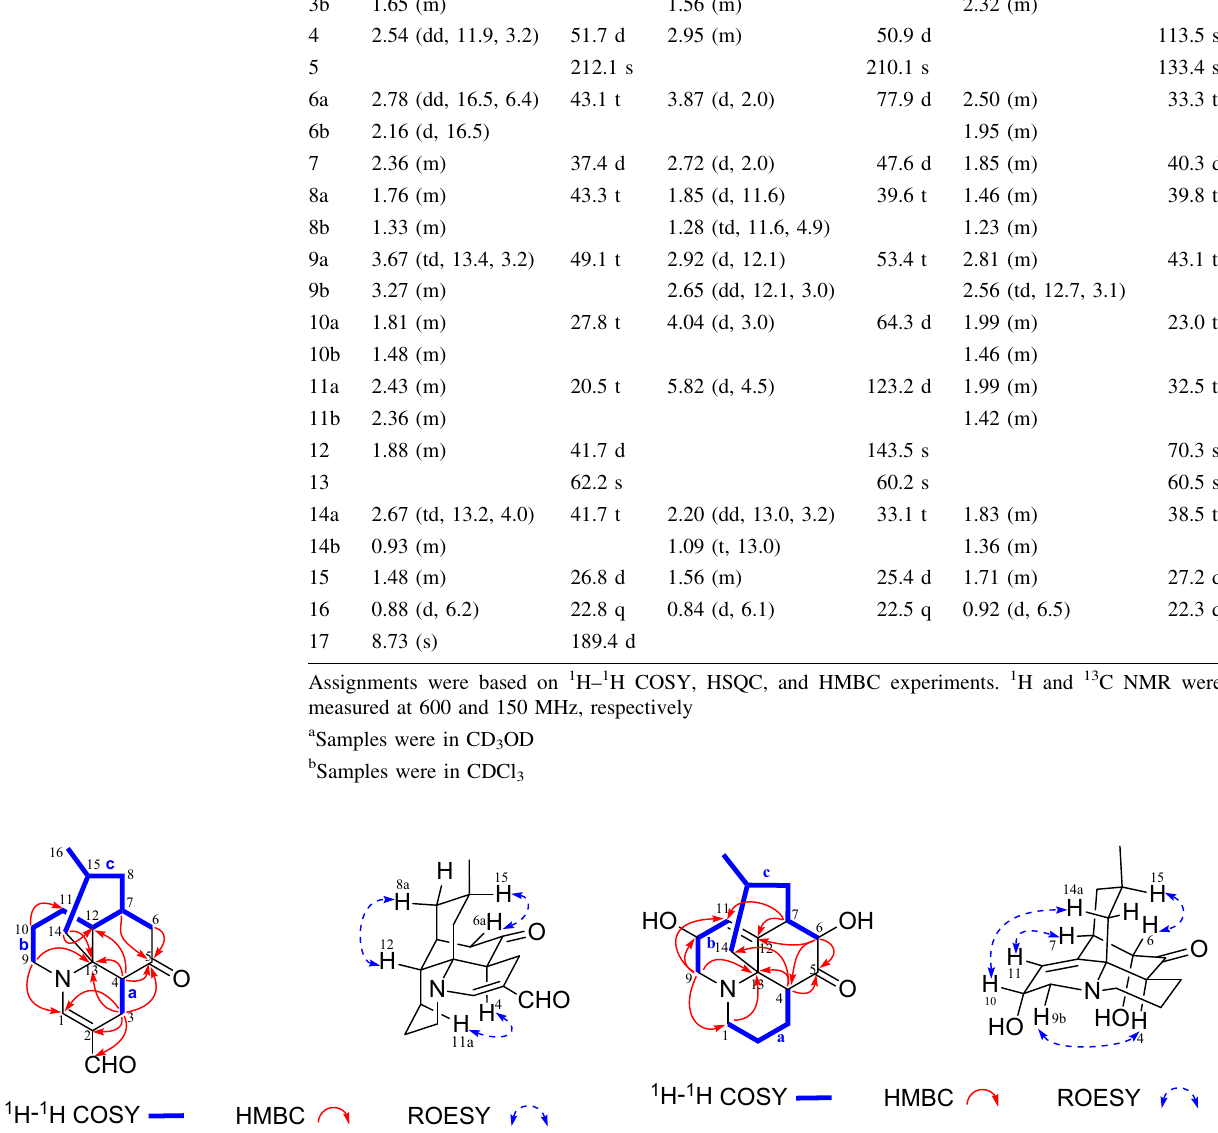
functional (1657 cm - 1 ) groups. The 13 C NMR (Table 1) spectroscopic data of 3 showed the exitence of 16 signals classified as one methyl resonated at d